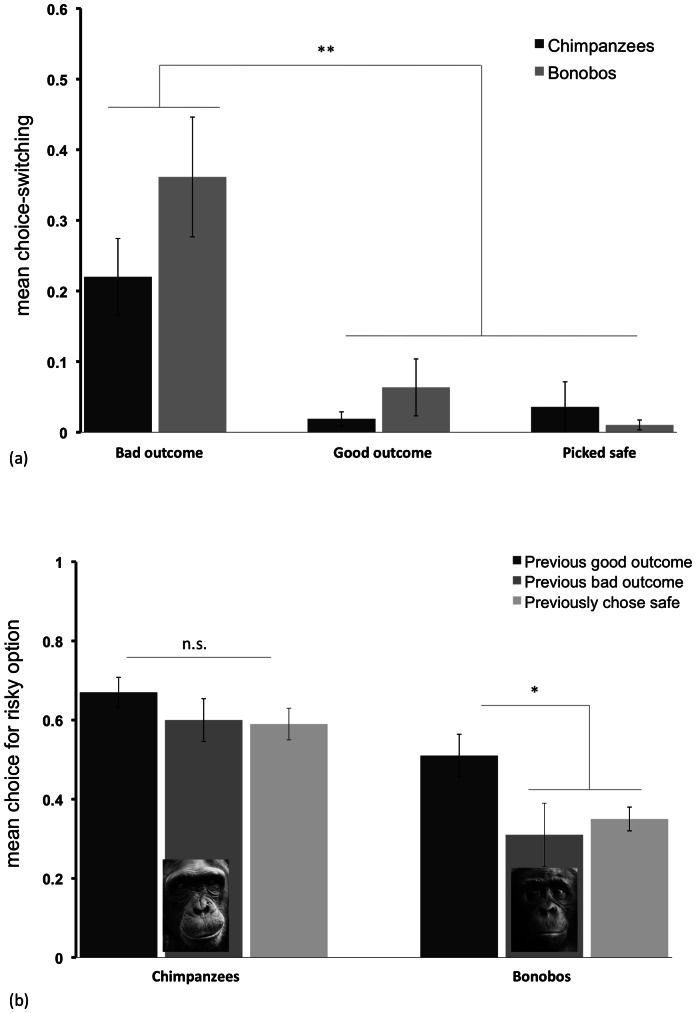
Choice switching and reward sensitivity in study 2.a) Chimpanzees and bonobos attempted to switch their choice in response to different outcomes in the risk task. b) The impact of previous trial outcome on current choice in chimpanzees and bonobos. Error bars represent standard error of mean.